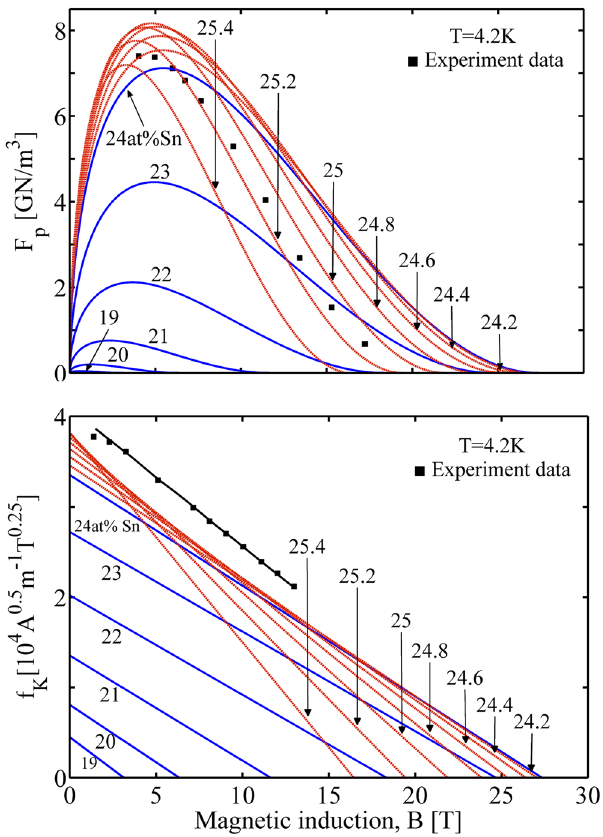
Figure 8. Effect of composition concentration on the magnetic field dependence of the flux pinning force (Top) and Kramer plot (Bottom). The experiment data are extracted from refs 10 and 28.